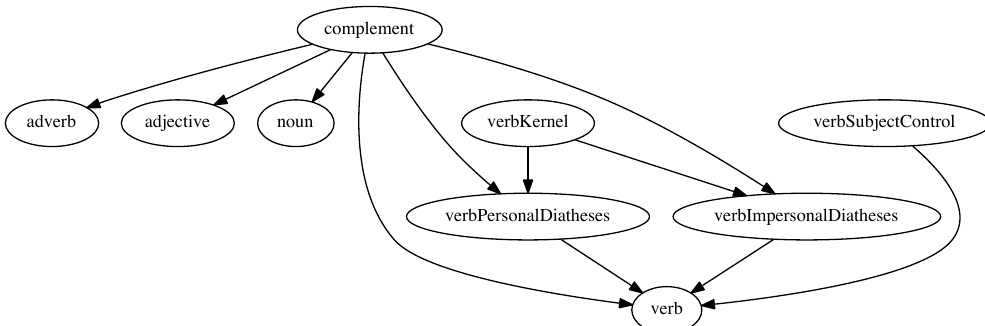
Figure 10: Hierarchy of modules grouping the classes of frigram S concerning verbs, nouns, adjectives, and adverbs